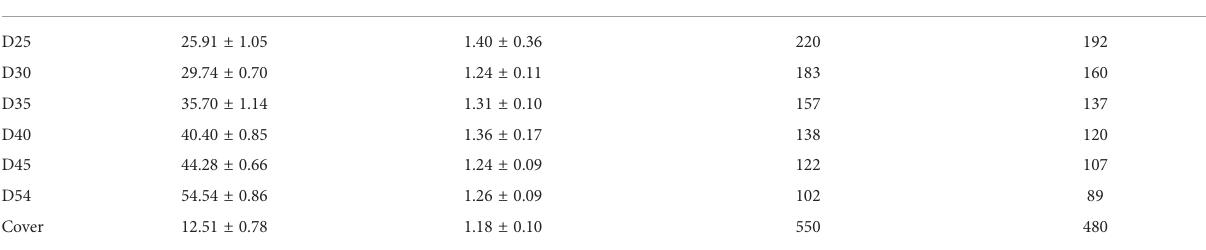
TABLE 1 Speci fi cations of the experimental codends and cover (SE refers to standard errors).